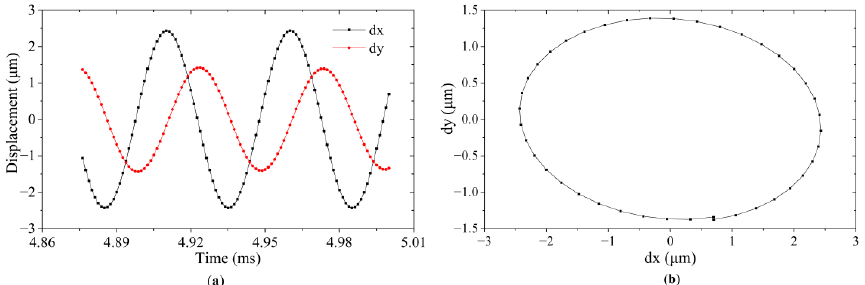
Figure 7. Vibration features of a vibrator driving point calculated by transient analysis at the frequency of 32 kHz: ( a ) Steady-state displacement; ( b ) Motion trajectory.